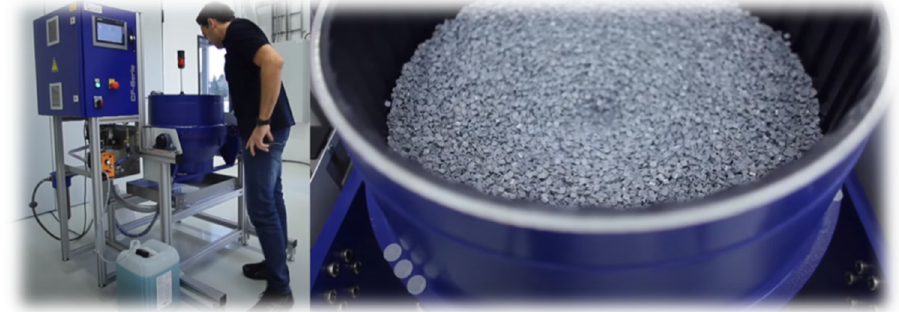
Figure 6. Tribofinition equipment.